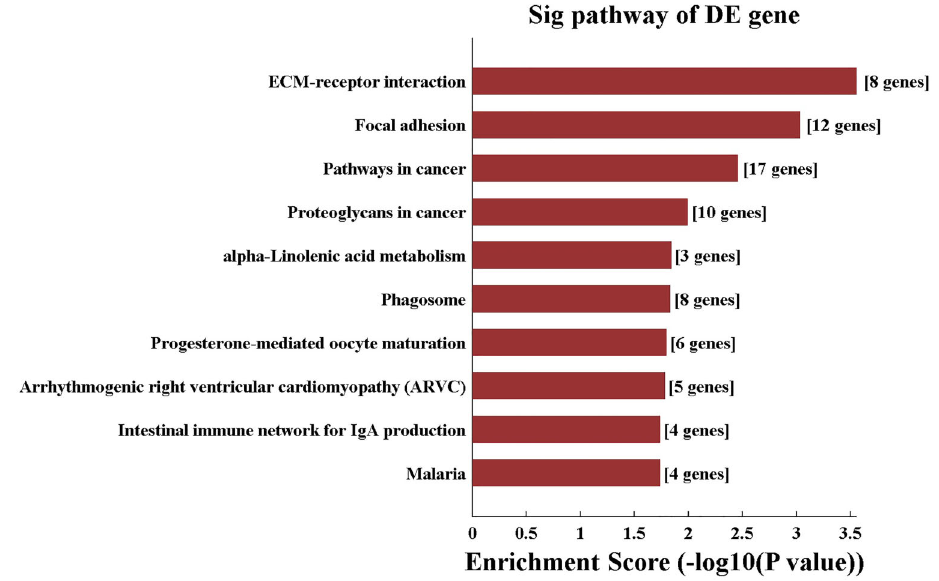
Figure 4. qRT-PCR validation of 5 selected differentially expressed genes in pancreaticobili- ary maljunction (PBM). Each spot represents the gene expression value (corrected by b -actin housekeeping gene ( DD Ct)) of an individual patient (n=10). Midline represents the mean. **P o 0.001 (rank sum test). CTRL: